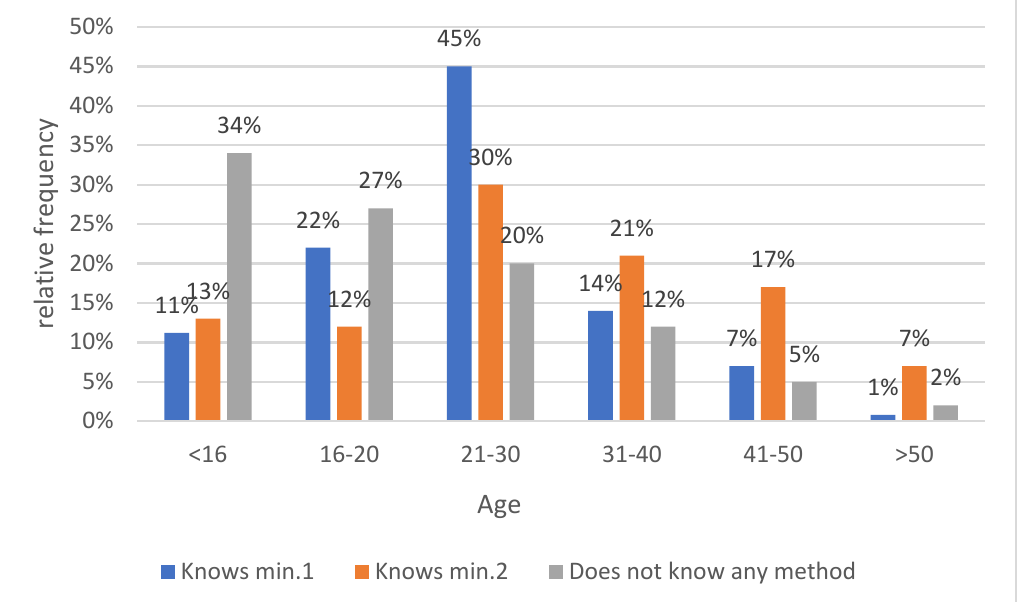
Figure 6. Knowledge of alternative methods to prevent malaria.